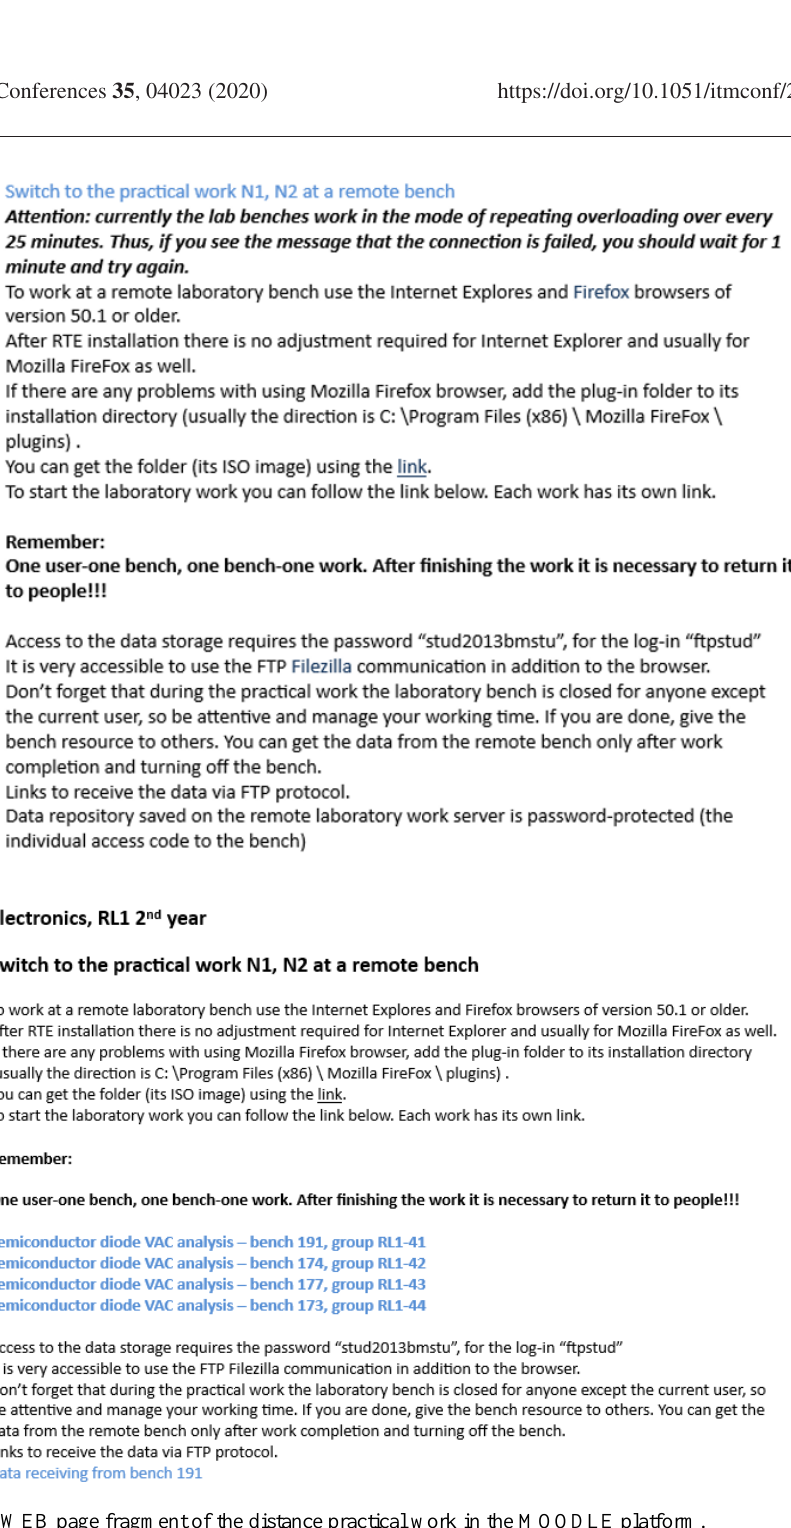
Fig. 7. WEB page fragment of the distance practical work in the MOODLE